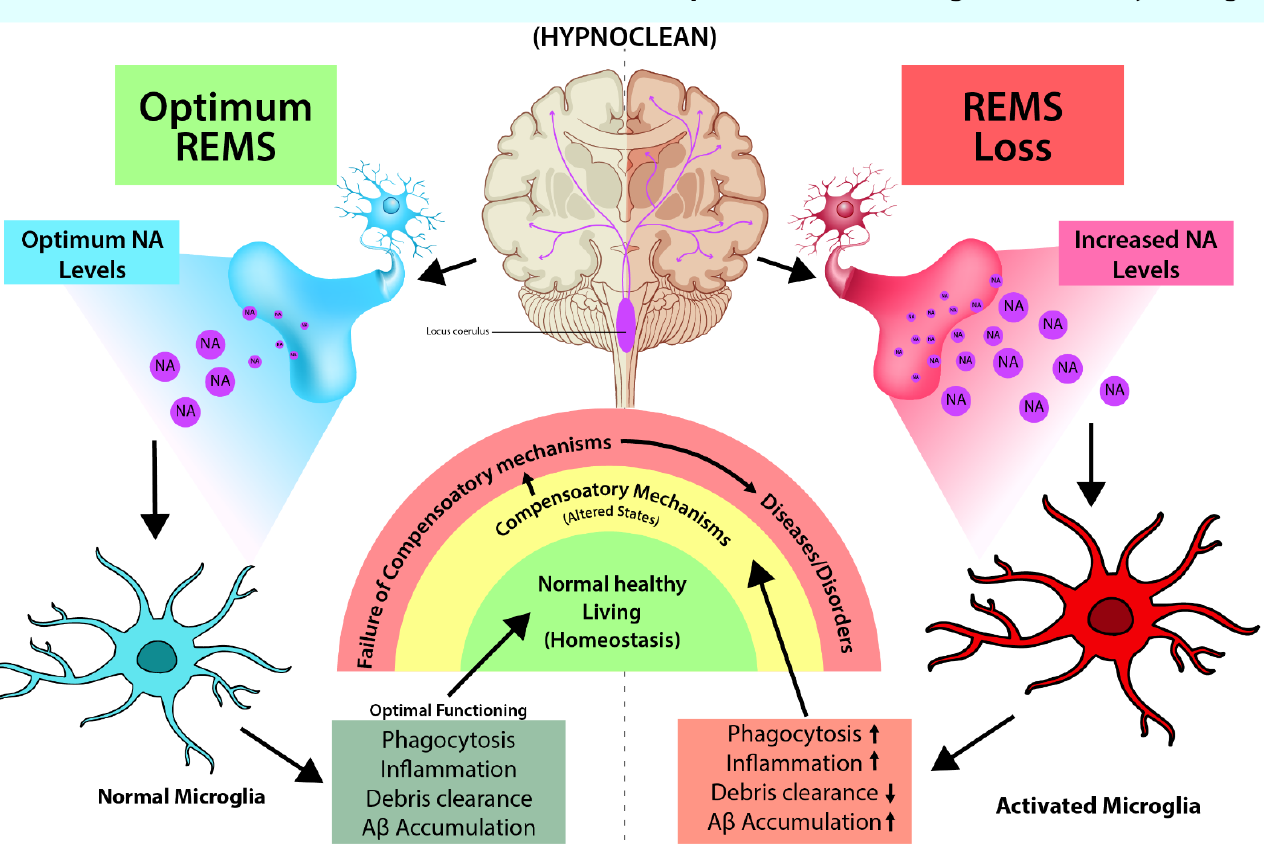
Figure 2. REMS loss-induced elevated brain NA causes many associated symptoms, such as immune dysfunctions, reduced waste clearance, etc., which can be ameliorated by preventing NA action (Sugama & Kakinuma, 2021; Sugama et al., 2019; Liu et al., 2019). We propose that maintaining opti- mum brain NA level is necessary for healthy living. We coined and introduced the term Hypnoclean to explain the overall